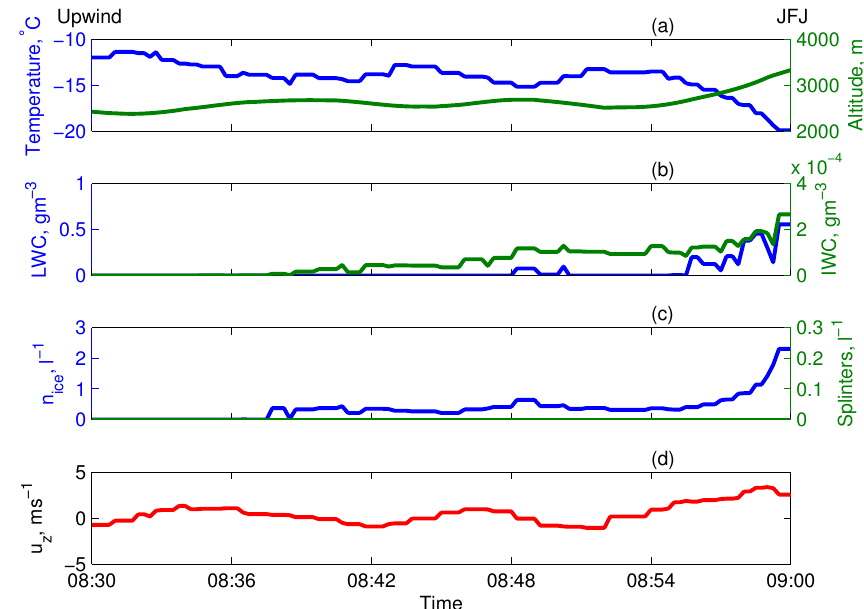
Figure 10. As for Fig. 9 but from the WRF simulation of 26 January 2014 at 09:00UTC.